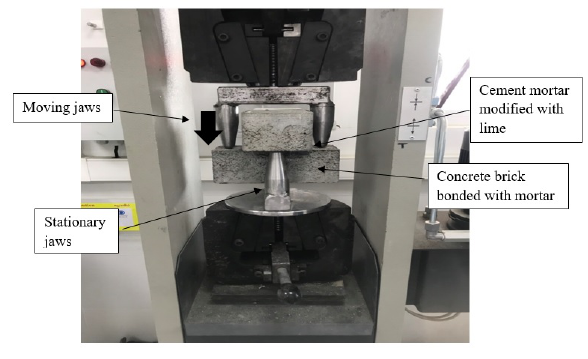
Figure 3: Cement mortar modified with lime under tensile bonding load